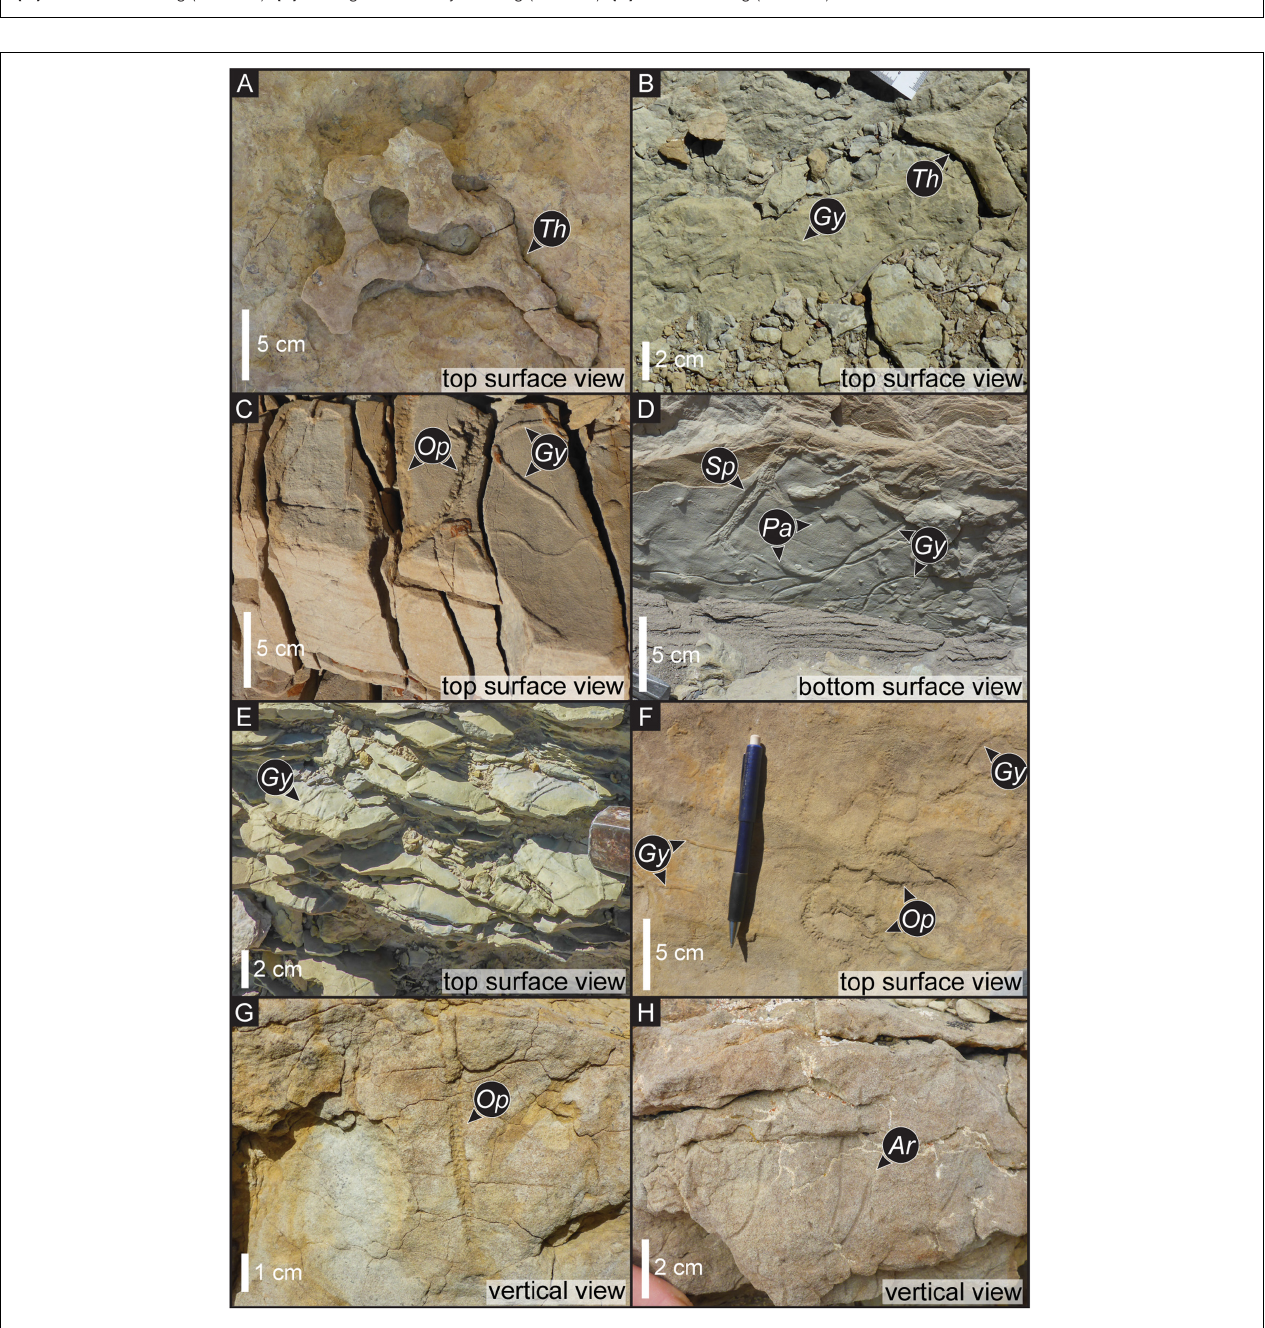
FIGURE 3 | Representative overview of recorded fossils— Thalassinoides (Th), Gyrochorte (Gy), Ophiomorpha (Op), Spongeliomorpha (SP), Palaeophycus (Pa), and Arenicolites (Ar); photographs cover selected facies and are not meant as indicating exclusivity of trace fossil. (A) Flaser bedding top surface view (Facies Q). (B) Wavy bedding top surface view (Facies P). (C) HCS top surface view (Facies G). (D) Wavy bedding bottom surface view (Facies P). (E) Lenticular bedding top surface view (Facies O). (F) Wavy bedding top surface view (Facies P). (G) SCS vertical view (Facies H). (H) Trough cross-strata with reactivation surfaces vertical view (Facies